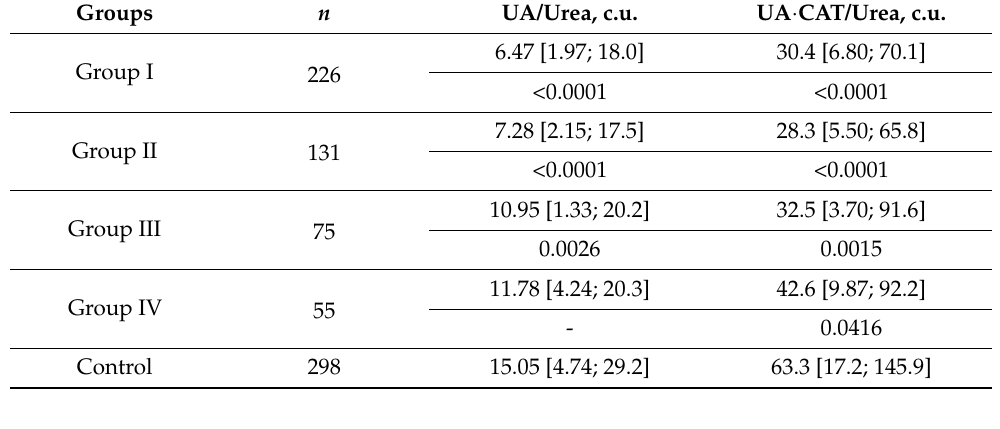
Table 3. Ratios of biochemical indicators of breast cancer patients depending on the stage. Groups n UA/Urea, c.u. UA · CAT/Urea, c.u.